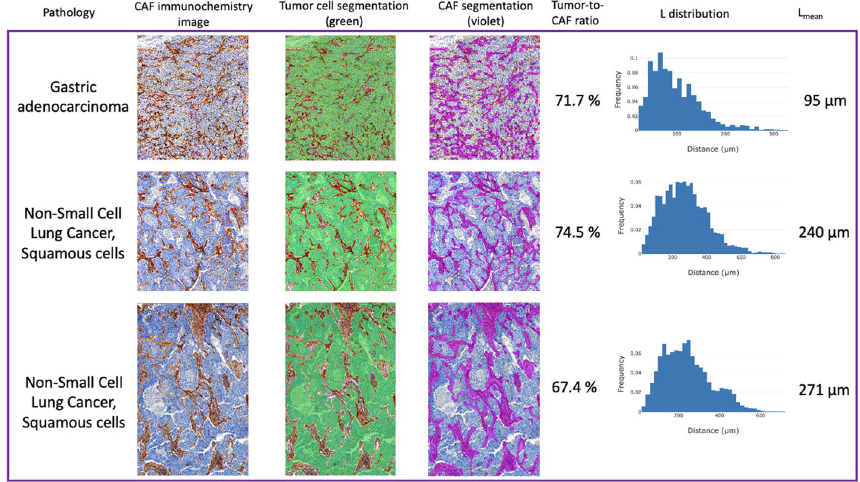
Fig. 3 Three images of CAF immunochemistry with associated CAF and tumor segmentation, tumor ratio, nearest CAF for each tumor distance (L) distribution and L